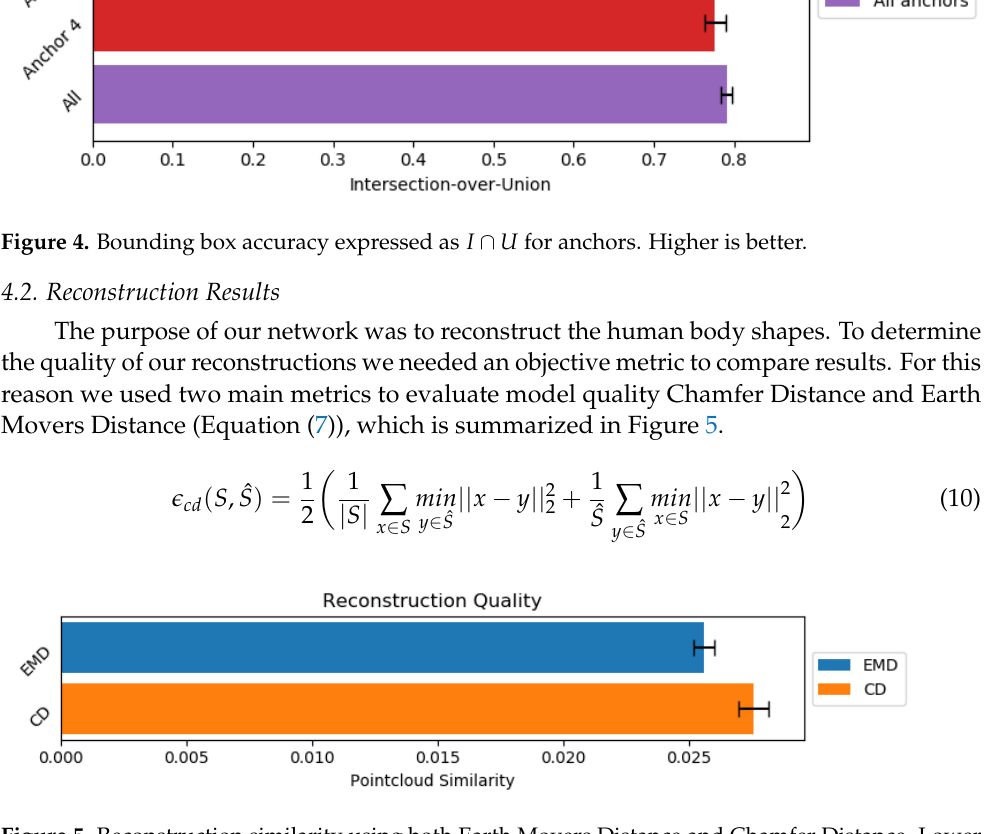
Figure 5. Reconstruction similarity using both Earth Movers Distance and Chamfer Distance. Lower value is